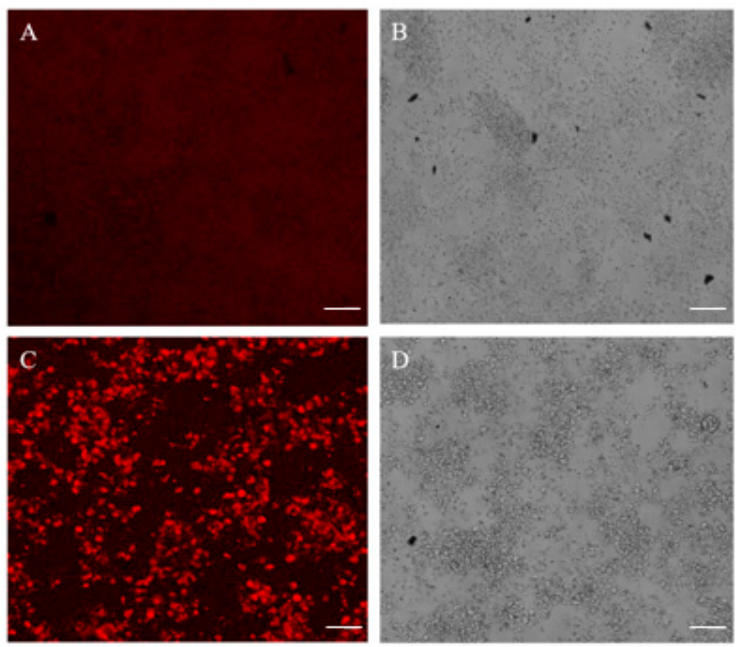
Figure 4. Glucose uptake induced by SMA-insulin micelles. Confocal images of fluorescent 2-DG uptake in HepG-2 cells untreated ( A , B ) and SMA-insulin treated ( C , D ) for 3 h. HepG-2 cells were seeded in a six-well plate for two days. HepG-2 cells were starved before the addition of 10 mM of fluorescent 2-DG. These pictures were done in triplicate; representative images are shown. Scale bar 200 μ m.